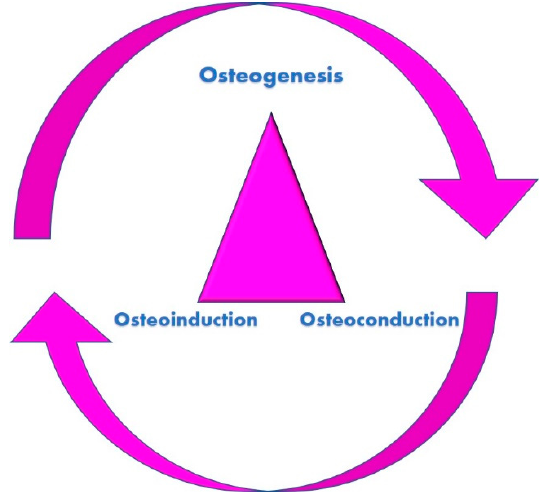
Figure 1. The three properties fundamental for bone regeneration. The scaffold network allows the migration of the cells (osteoconduction). Subsequently, the growth factors provided by the vascular supply induce the cellular proliferation (osteoinduction). Finally, the osteoblasts form new bone tissue (osteogenesis).